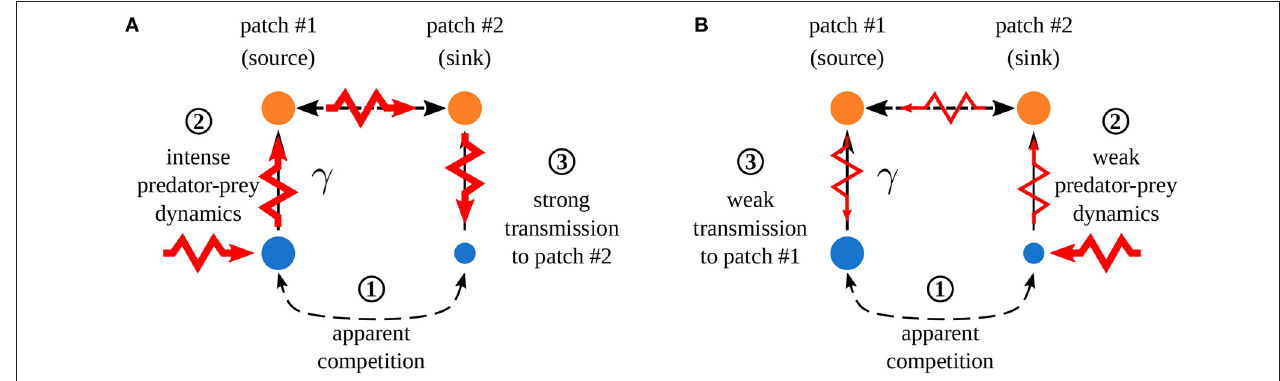
FIGURE 8 | Effect of spatial heterogeneity on synchrony. Asymmetry of interaction strength γ leads to a strong apparent competition 1 , creating biomass difference between the two patches (disk size). (A) Perturbation of prey in patch #1 which 2 leads to strong responses of prey and predator biomasses due to abundant prey biomasses and high interaction strength. 3 Strong transmission in patch #2 increasing the correlation of prey populations (control of prey populations by predators). (B) Perturbation of prey in patch #2 which 2 leads to weak predator-prey dynamics due to low prey biomass and low interaction strength. 3 Weak transmission in patch #2 leading to almost independent recovery in each patch, which decreases correlation. Adapted from Quévreux et al. (in prep.).